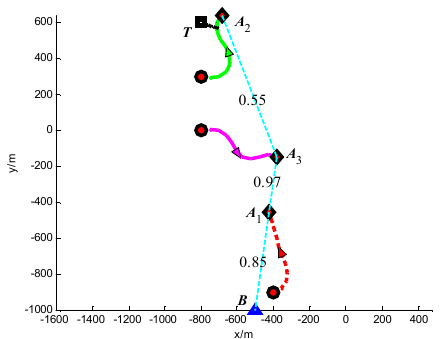
Figure 27. Trajectories of UAVs and target at t = 10 s (Group A in Scenario 3).